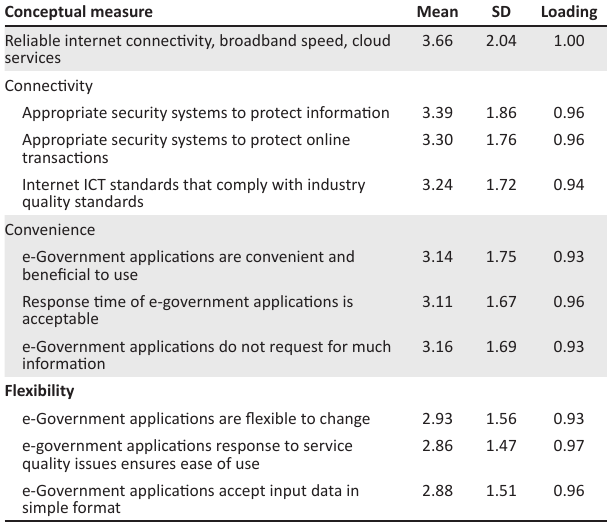
TABLE 6: Confirmatory factor analysis of technology infrastructure readiness.